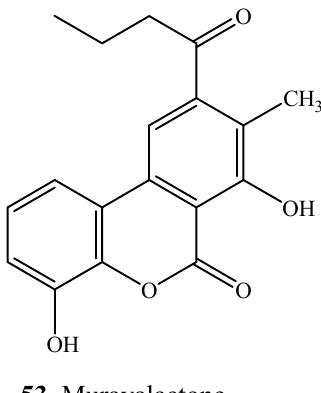
Figure 5. The structure of murayalactone ( 53